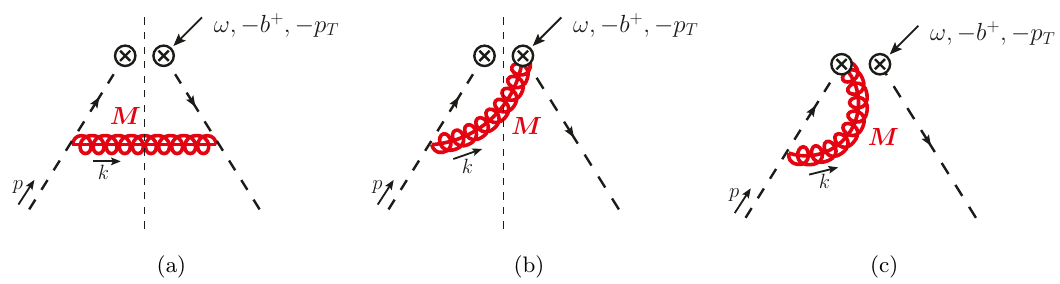
Figure 20 . Light-quark beam function diagrams for massive gluon radiation at one loop. In addition, also the wave function renormalization correction and the mirror diagrams for (b) and (c) have to be included in the